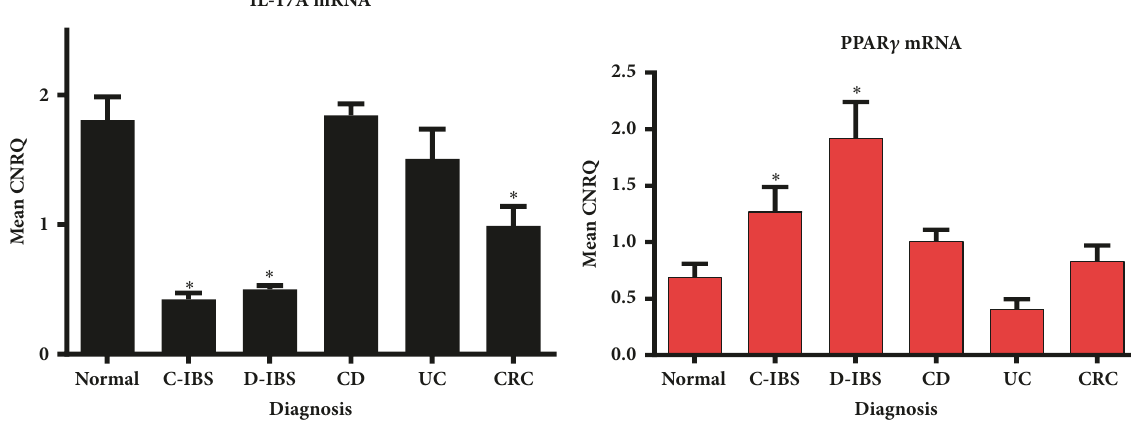
Figure 5: (a) Interleukin-17AmRNA. CNRQ = Calibrated Normalized Relative Quantities, normalized to mean of all samples. Total patients studied = 65 with Normal group: thirteen (13) patients, C-IBS group: eighteen (18) patients, D-IBS group: six (6) patients, CD group: six (6) patients, UC group: six (6) patients, and CRC group: sixteen (16) patients. (b) PPAR 𝛾 mRNA expression. Total patient number studied = seventy-four (74) with Normal group: fifteen (15) patients, C-IBS group: twenty-two (22) patients, D-IBS group: eight (8) patients, CD group: six (6) patients, UC group: seven (7) patients, and CRC group: sixteen (16) patients. ∗ denotes significantly different versus normal group (p <